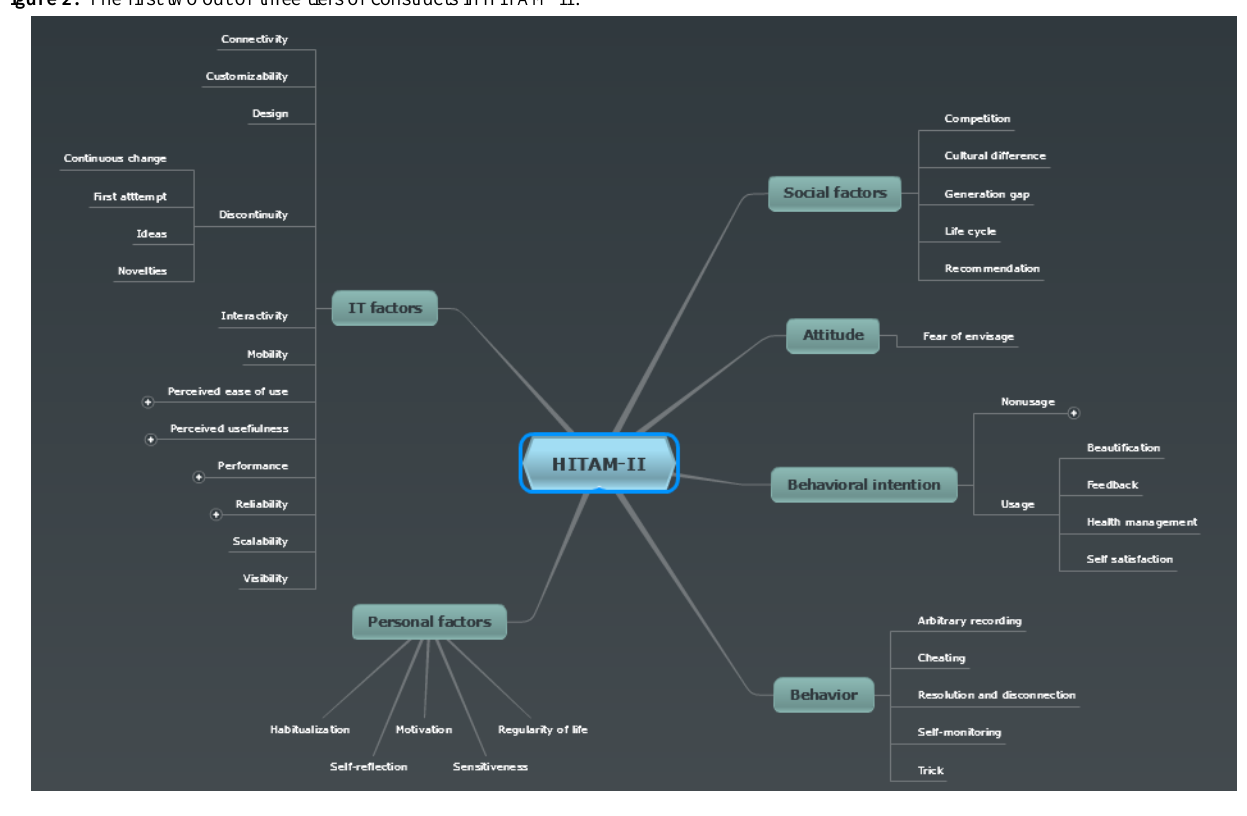
Figure 2. The first two out of three tiers of constructs in HITAM-II.